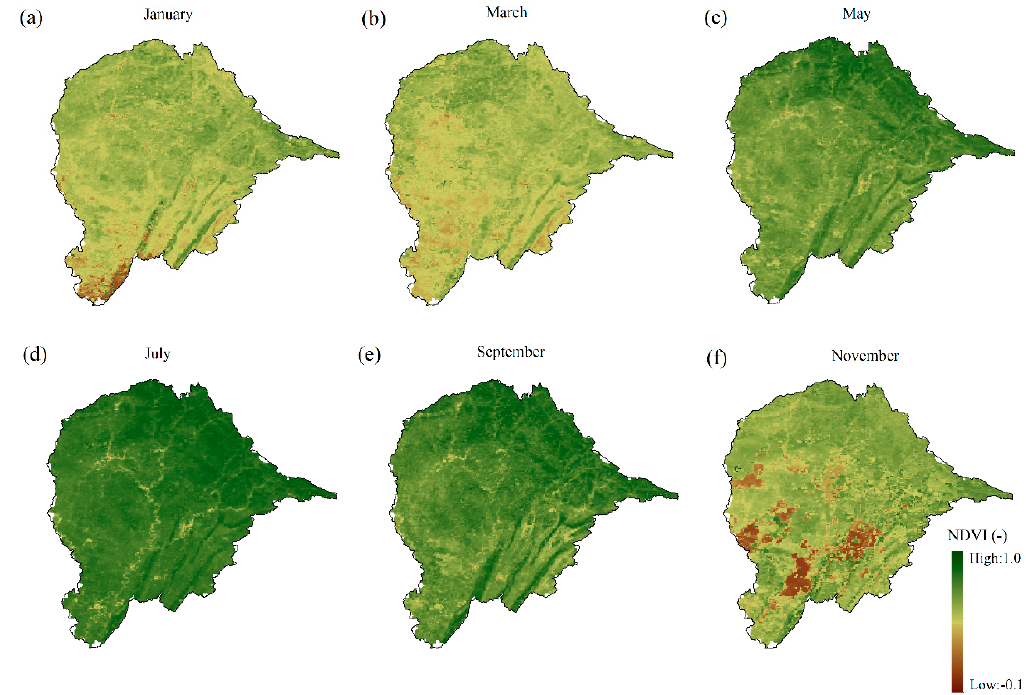
Figure 2. Normalized Difference Vegetation Index (NDVI) in different months of the year 2016 for the Qujiang catchment.